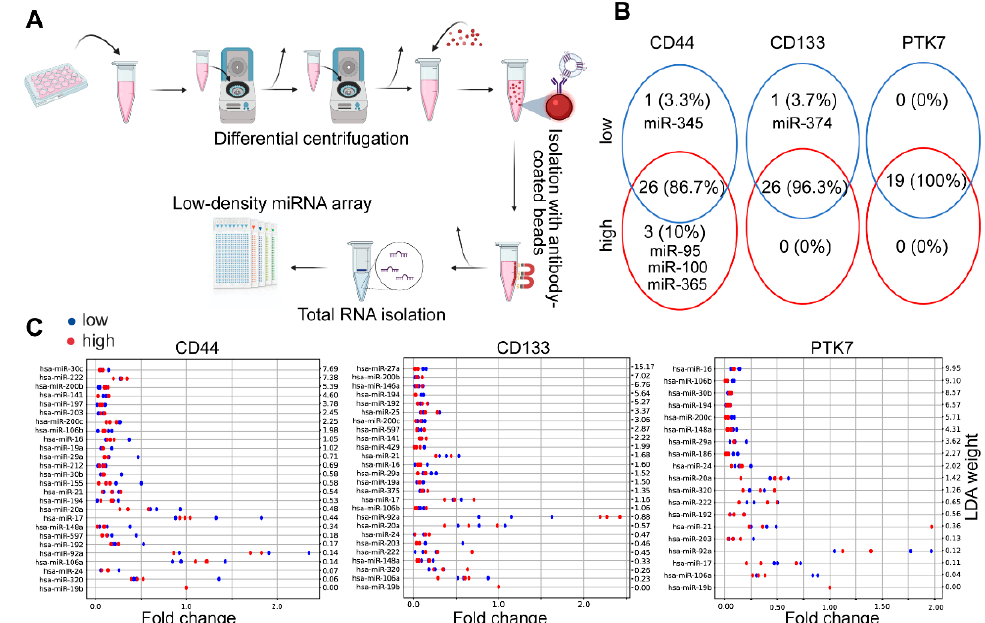
Figure 4. No large difference in the EV miRNA cargo between CD44 high and CD44 low , CD133 high and CD133 low , PTK7 high and PTK7 low cells. ( A ) The workflow of the EV isolation and miRNA cargo analysis. ( B ) Venn diagram of the overlapping and non-overlapping miRNAs, detected on day7 after organoid initiation from the sorted cells. The number and the percentage of the miRNAs are represented. ( C ) LDA analysis of the normalized miRNA levels. Note that miRNAs present in all samples of the corresponding experimental groups were selected.